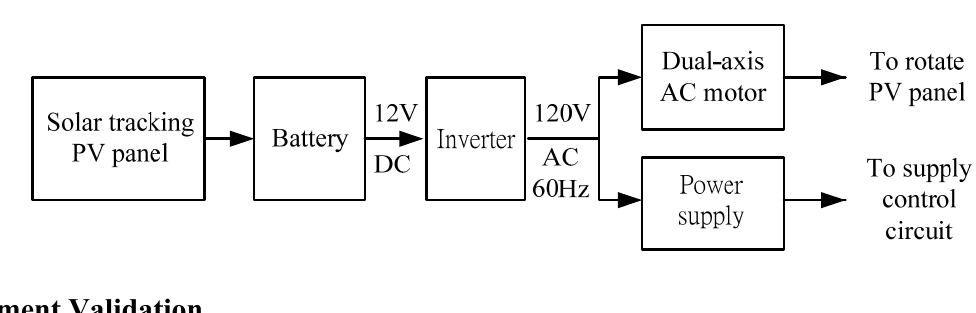
Figure 7. Stand-alone PV power